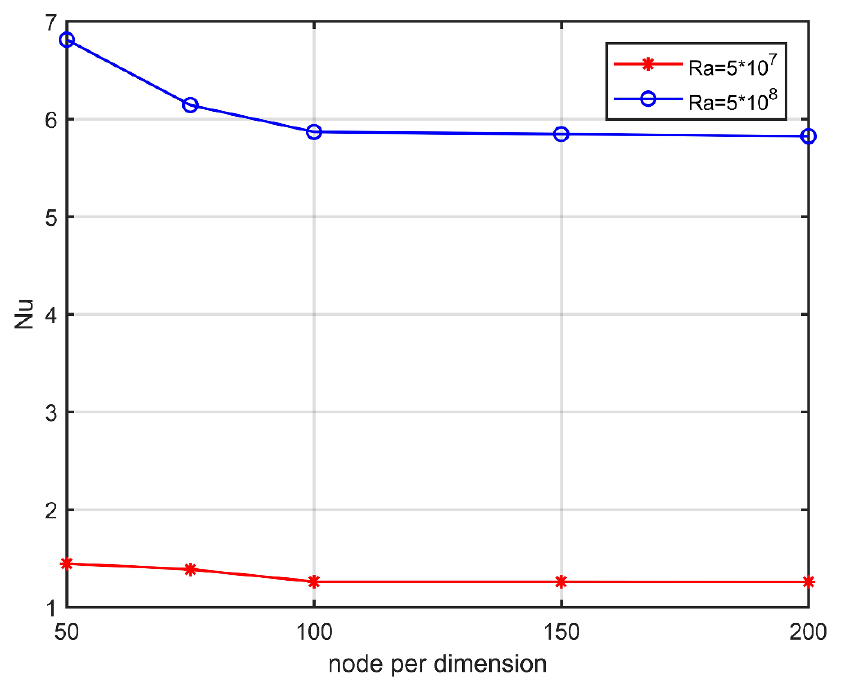
Figure 3. Convergence analysis for Nu ave along the hot wall. Variation with Ra .